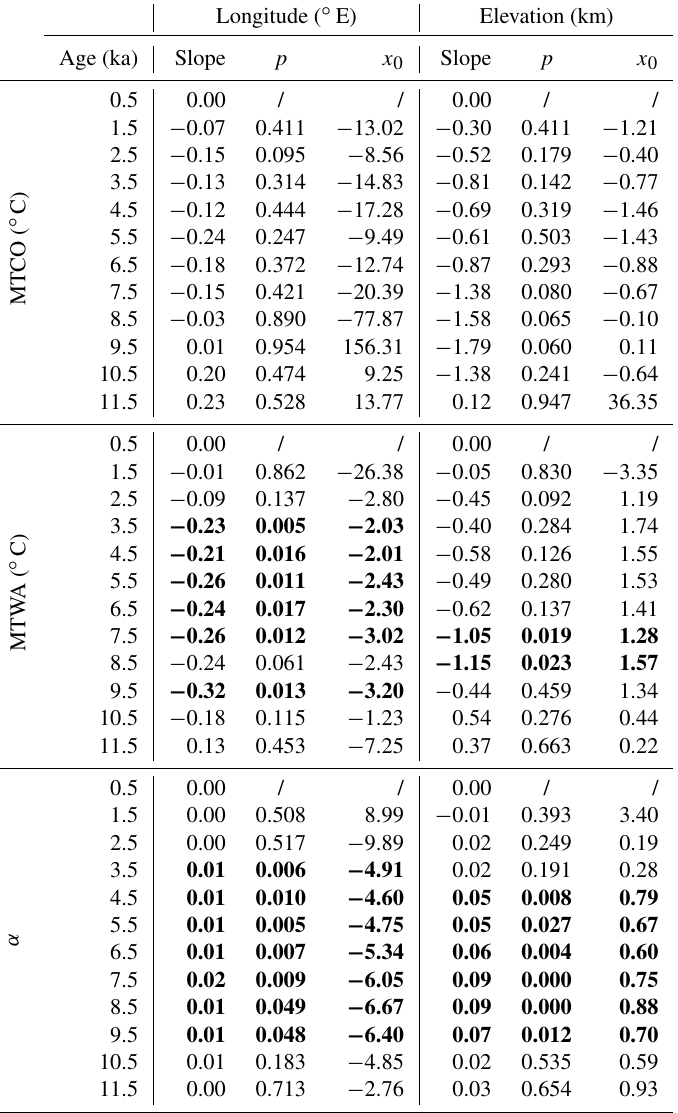
Table 4. Assessment of the significance of anomalies to 0.5ka through time with longitude and elevation. The slope is obtained by linear regression of the anomaly onto the longitude or elevation; p is the significance of the slope (bold parts: p < 0.05); x 0 is the point where the anomaly is 0 in the linear equation, which indicates longitude or elevation where the anomaly changes